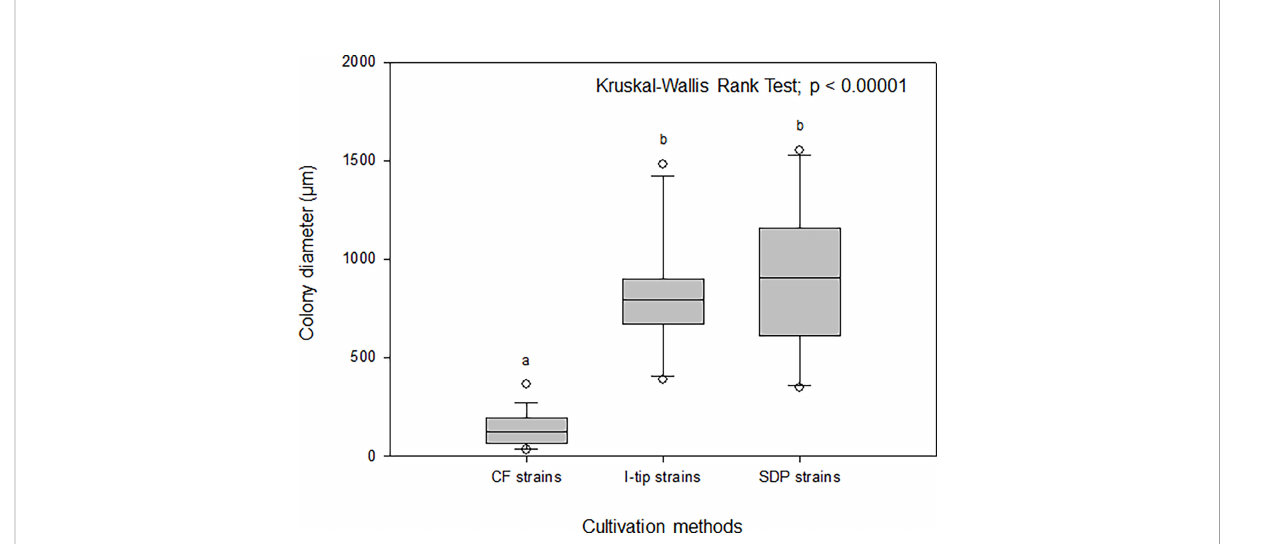
FIGURE 8 Box-and-whisker plots of colony diameter for CF (continuous- fl ow bioreactor), I-tip and SDP (standard direct plating) strains. The line inside each box indicates the median value. Lines extending from the boxes represent minimum and maximum values excluding outliers. Closed circles indicate the mean. Average colony diameter of each selected strain was measured by randomly selected 20 colonies on agar plate. Average colony diameter was compared among cultivation methods using the Kruskal-Wallis procedure. Letters above boxes indicate signi fi cant differences using post-hoc Dunn ’ s